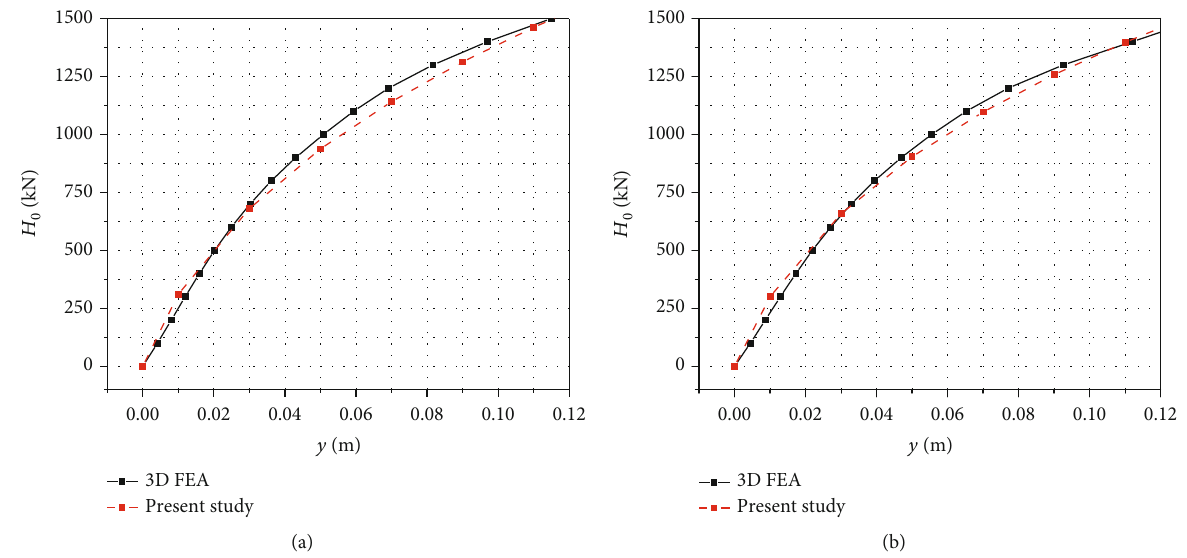
Figure 12: Load and displacement curve of pile head predicted for Case 2. (a) Considering Z